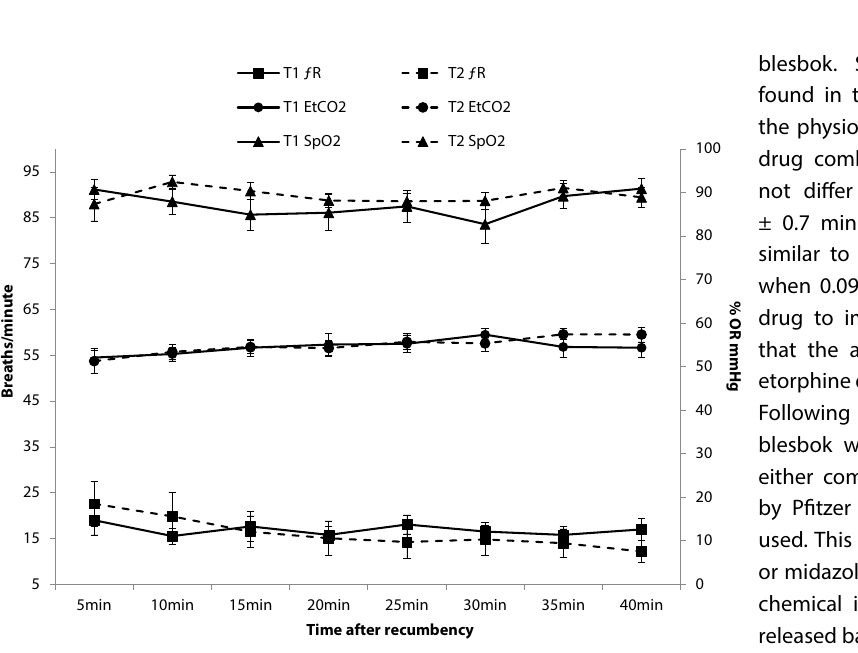
, EtCO and SpO ) over time in blesbok treated R 2 2